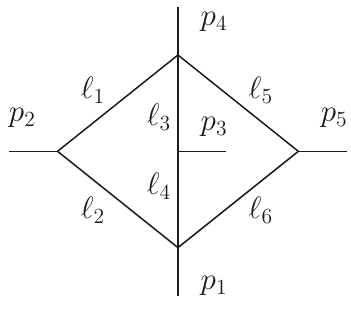
Figure 3 . Integral of topology